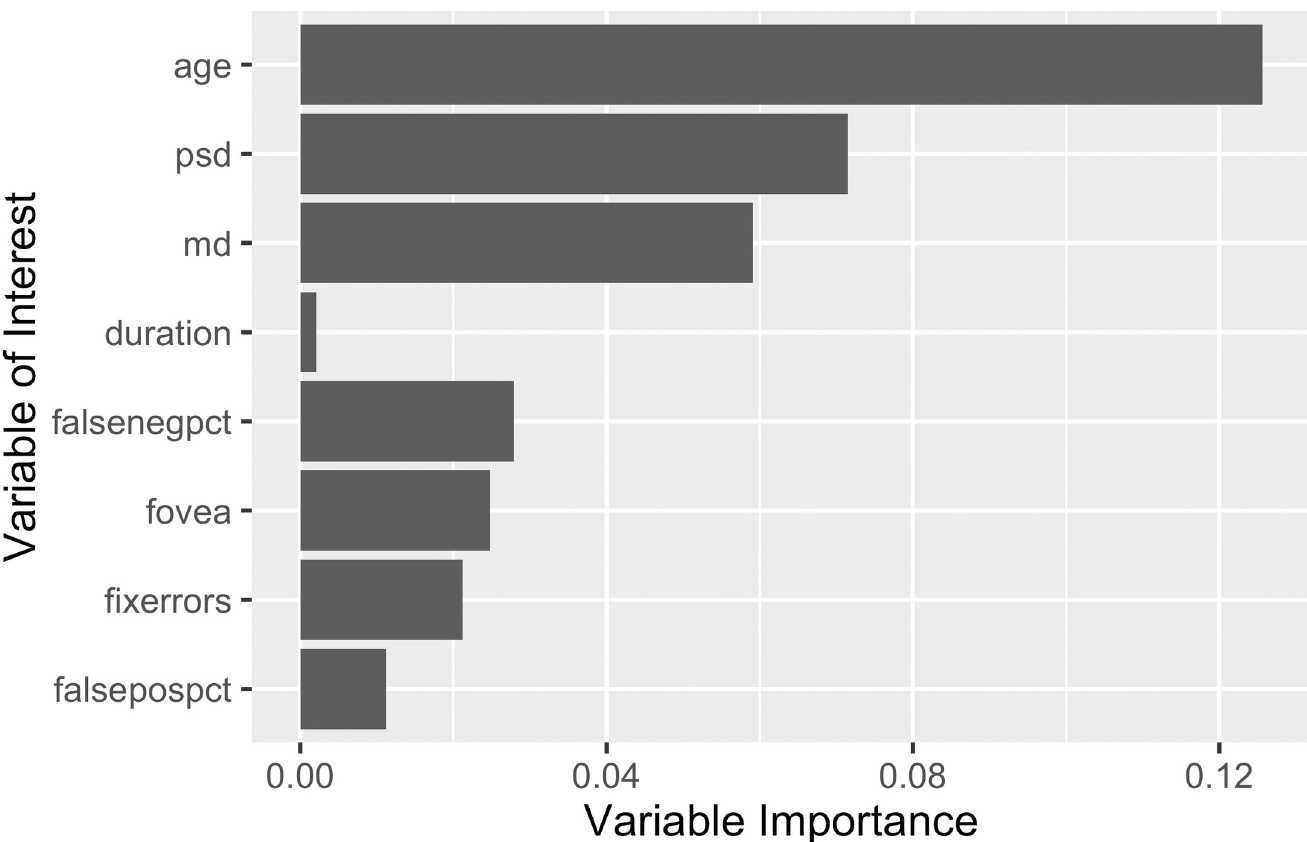
Fig 5. Breiman-Cutler variable importance metrics of the inputs for the random forest model.